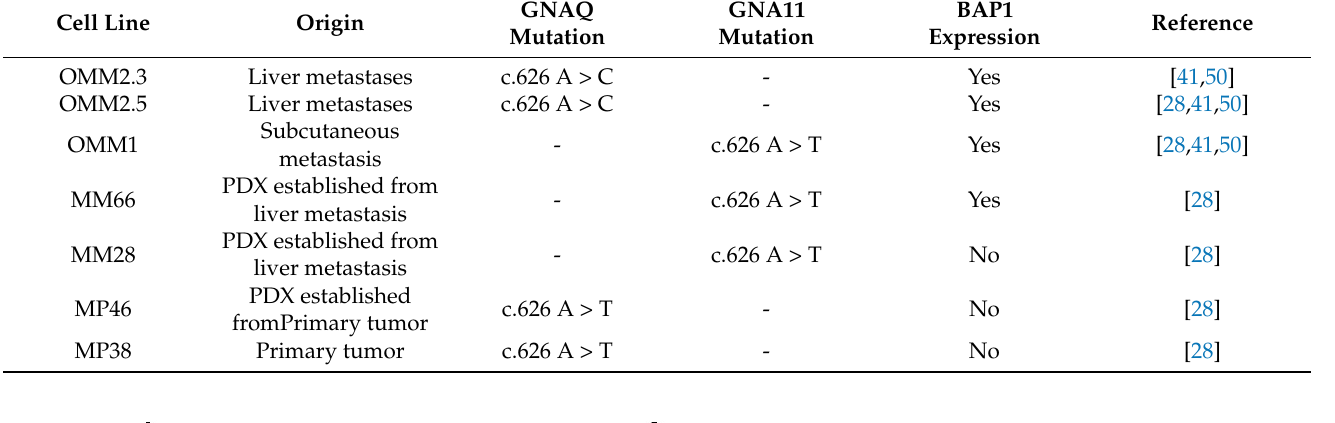
Table 1. Uveal melanoma cell lines.